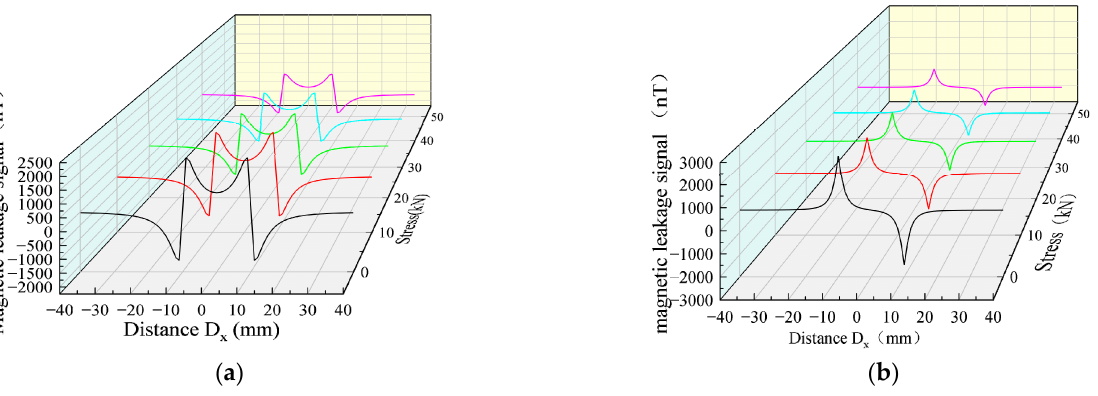
Figure 6. Changes of MFL signals under different stresses. ( a ) Axial components of MFL signals under different stresses. ( b ) Radial components of MFL signals under different stresses.